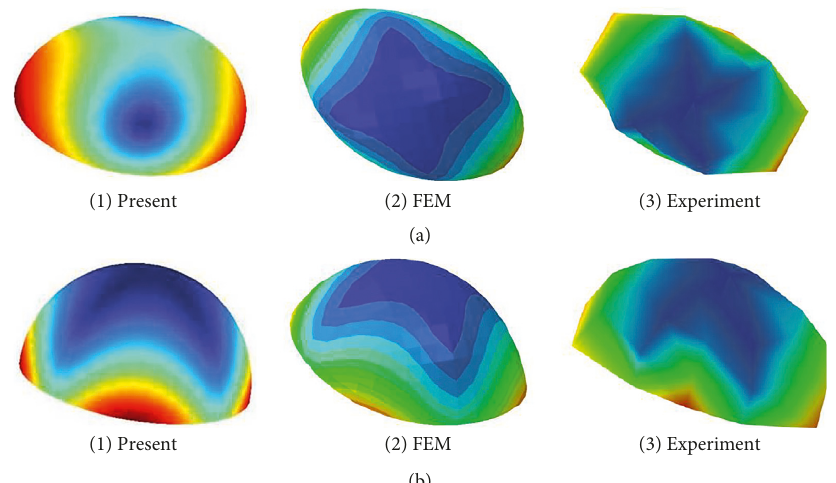
Figure 9: Comparison of the first two mode shapes of the present method, FEM, and experiment. (a) The first mode shape ( n (b) The second mode shape ( n